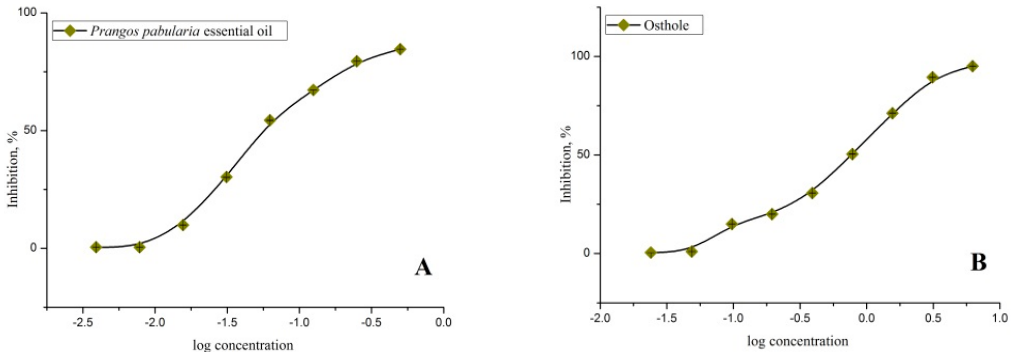
Figure 3. Dose response curve of inhibition of protein-tyrosine phosphatase 1B (PTP-1B) enzyme for Prangos pabularia essential oil ( A ) (IC 50 = 0.06 ± 0.01 µ g / mL) and the pure compound osthole ( B ) (IC 50 = 0.93 ± 0.01 µ g / mL).